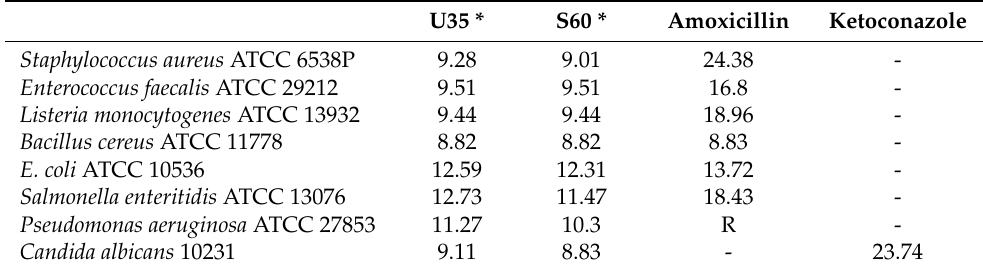
Table 8. Results for the risk diffusion test performed for selected samples.